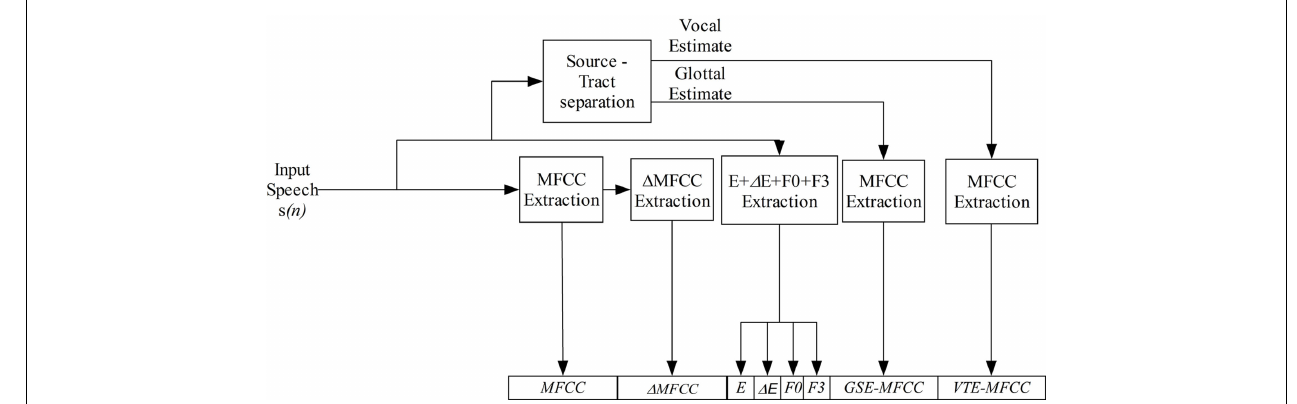
FIGURE 4 | General parameterization scheme used for both female and male speakers